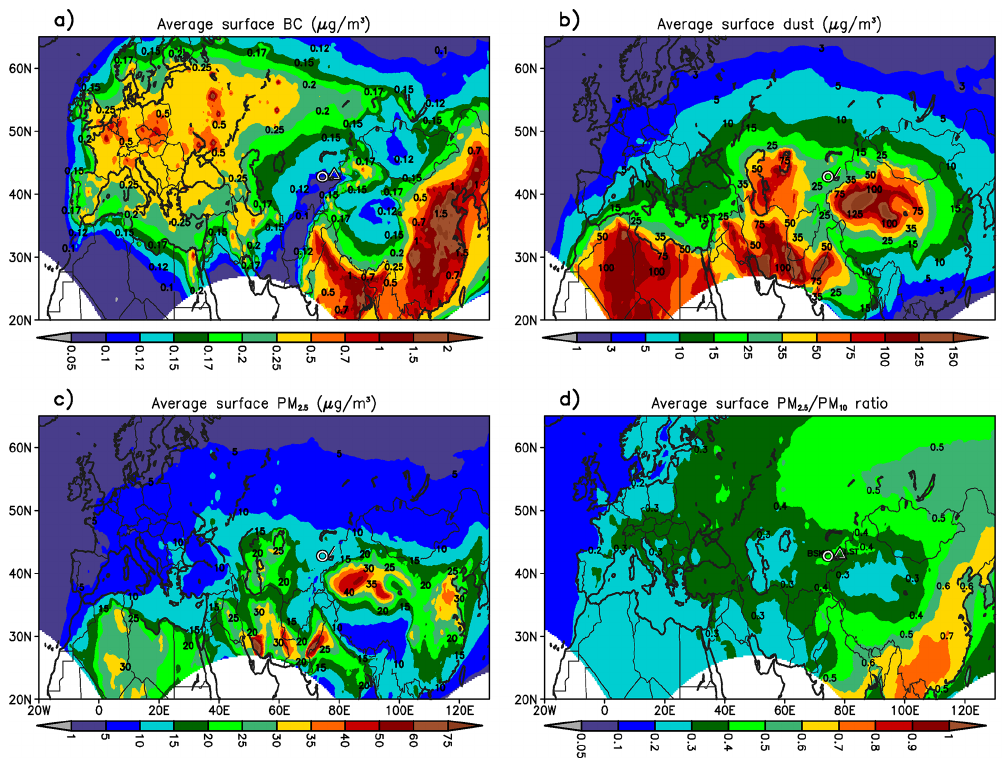
Figure 4. Spatial distribution of simulated (a) BC (µgm − 3 ) , (b) dust (µgm − 3 ) , (c) PM 2 . 5 (µgm − 3 ) , and (d) PM 2 . 5 /PM 10 ratio averaged over the simulation period. The values on the map denote contour values at sharp